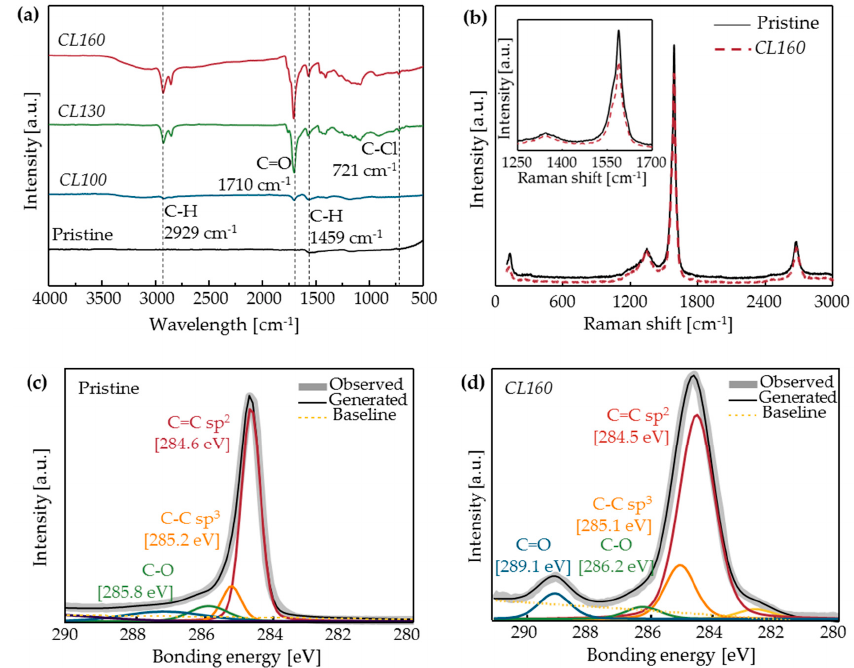
Figure 5. ( a ) The FT-IR spectroscopy of CNTs after cross-linking reactions at various temperatures. ( b ) Representative Raman spectra of the pristine CNTF and CL160 . XPS of ( c ) pristine CNTs and ( d ) CL160 . Cross-linking reaction was successful at 160 °C.